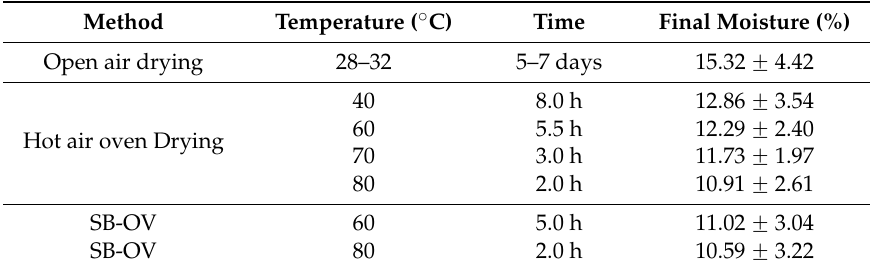
Table 3. Temperature, time and final moisture content of dried litchi